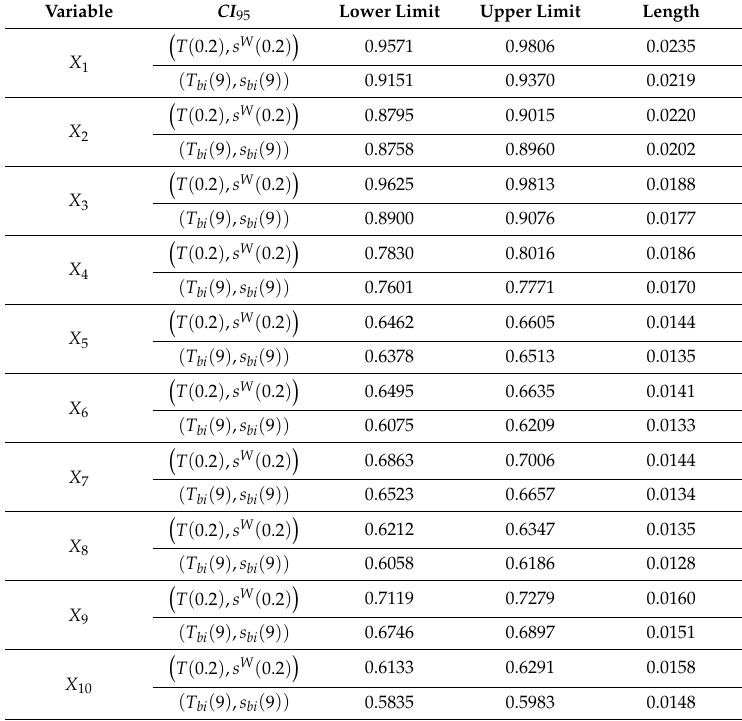
Table 5. 95% confidence intervals ( CI 0.95 ) and confidence interval lengths: ( T ( 9 ) , s ( 9 )) bi bi